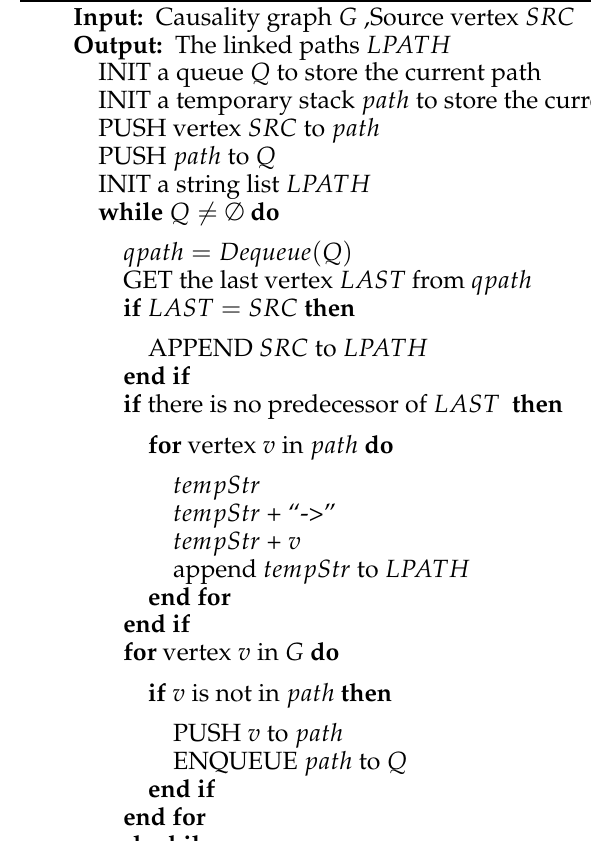
Algorithm 2: Casual search algorithm based on BFS